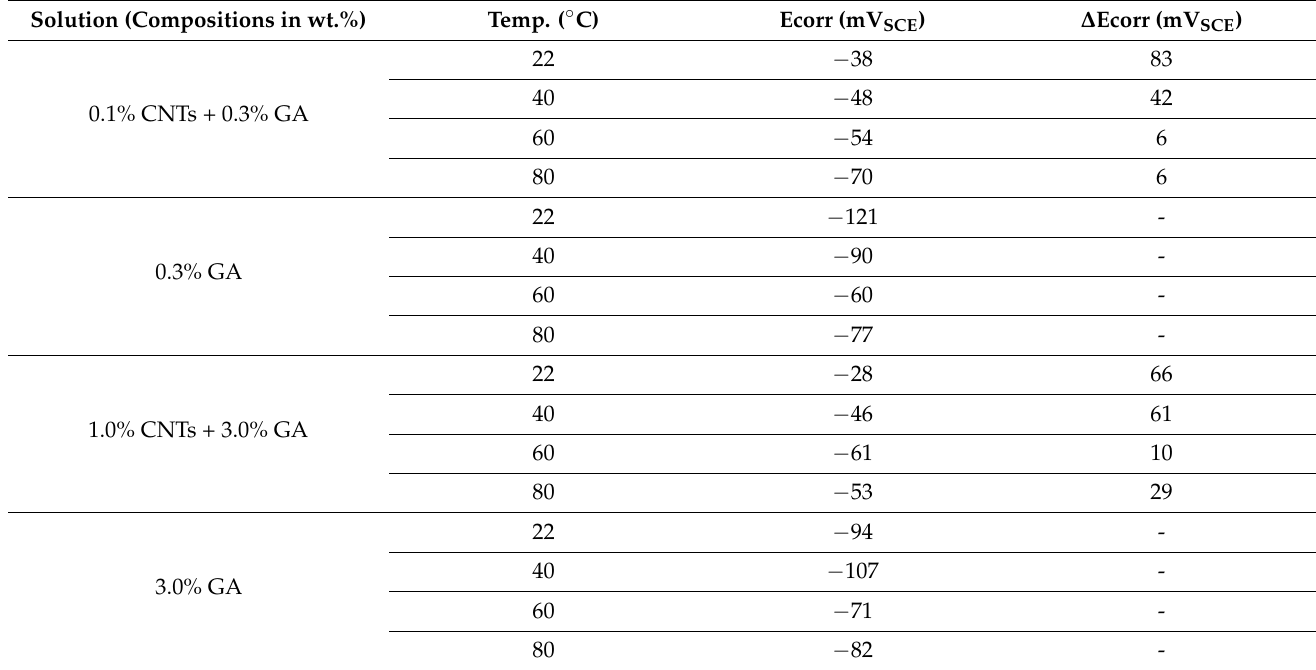
Table 4. Corrosion potential values for 316 L stainless steel tested in CNTs nanofluids and GA solutions at different temper- atures. Solution (Compositions in